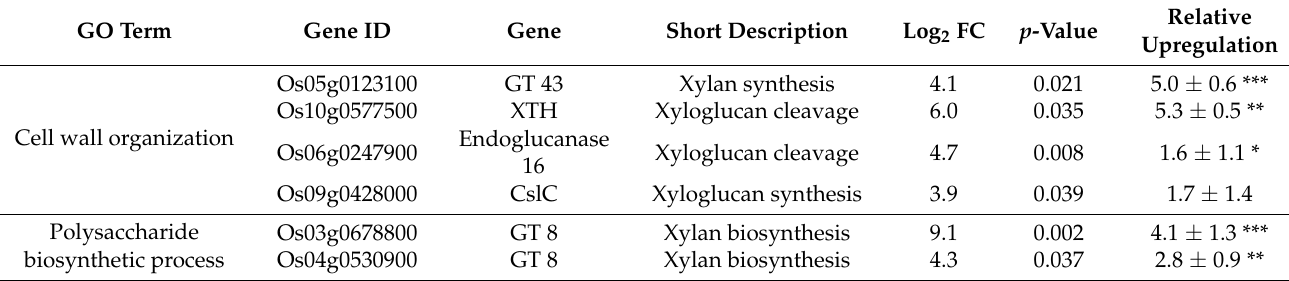
Table 2. Expression of secondary cell wall organization-related genes by RNA-seq and qRT-PCR (mean ± S.D.).